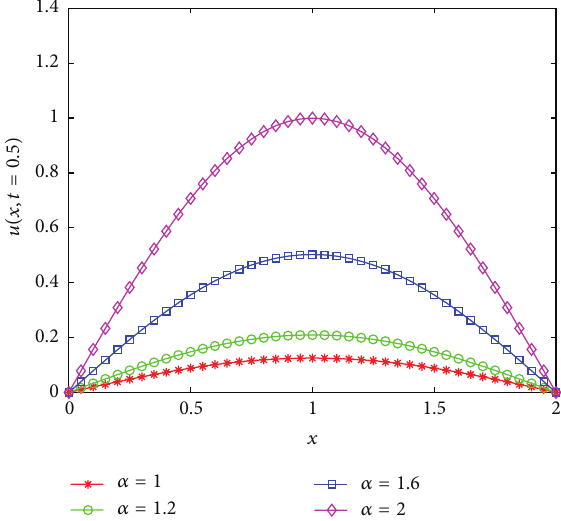
̂𝑅 𝑘 = O (𝜏 2 + ℎ 4 ) and ̃𝑅 𝑘 𝑙